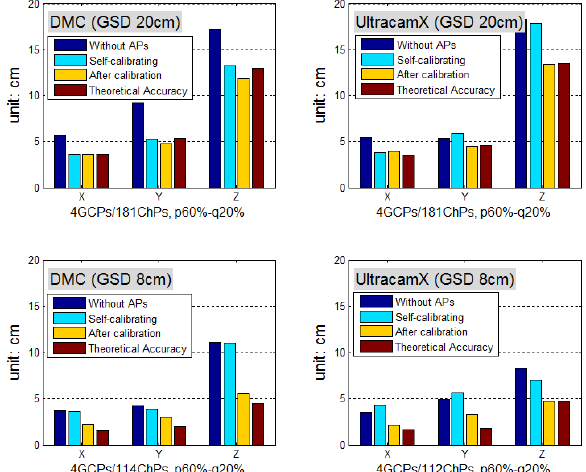
Fig. 2 External accuracy in four operational project blocks, 4 GCPs and p60%-q20% (‘without APs’ indicates without using Fourier APs